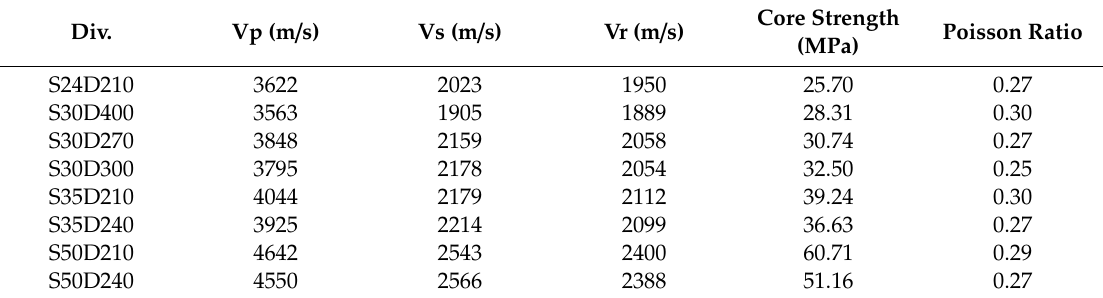
Table 8. The average values of wave velocity, core strength, and Poisson ratio.